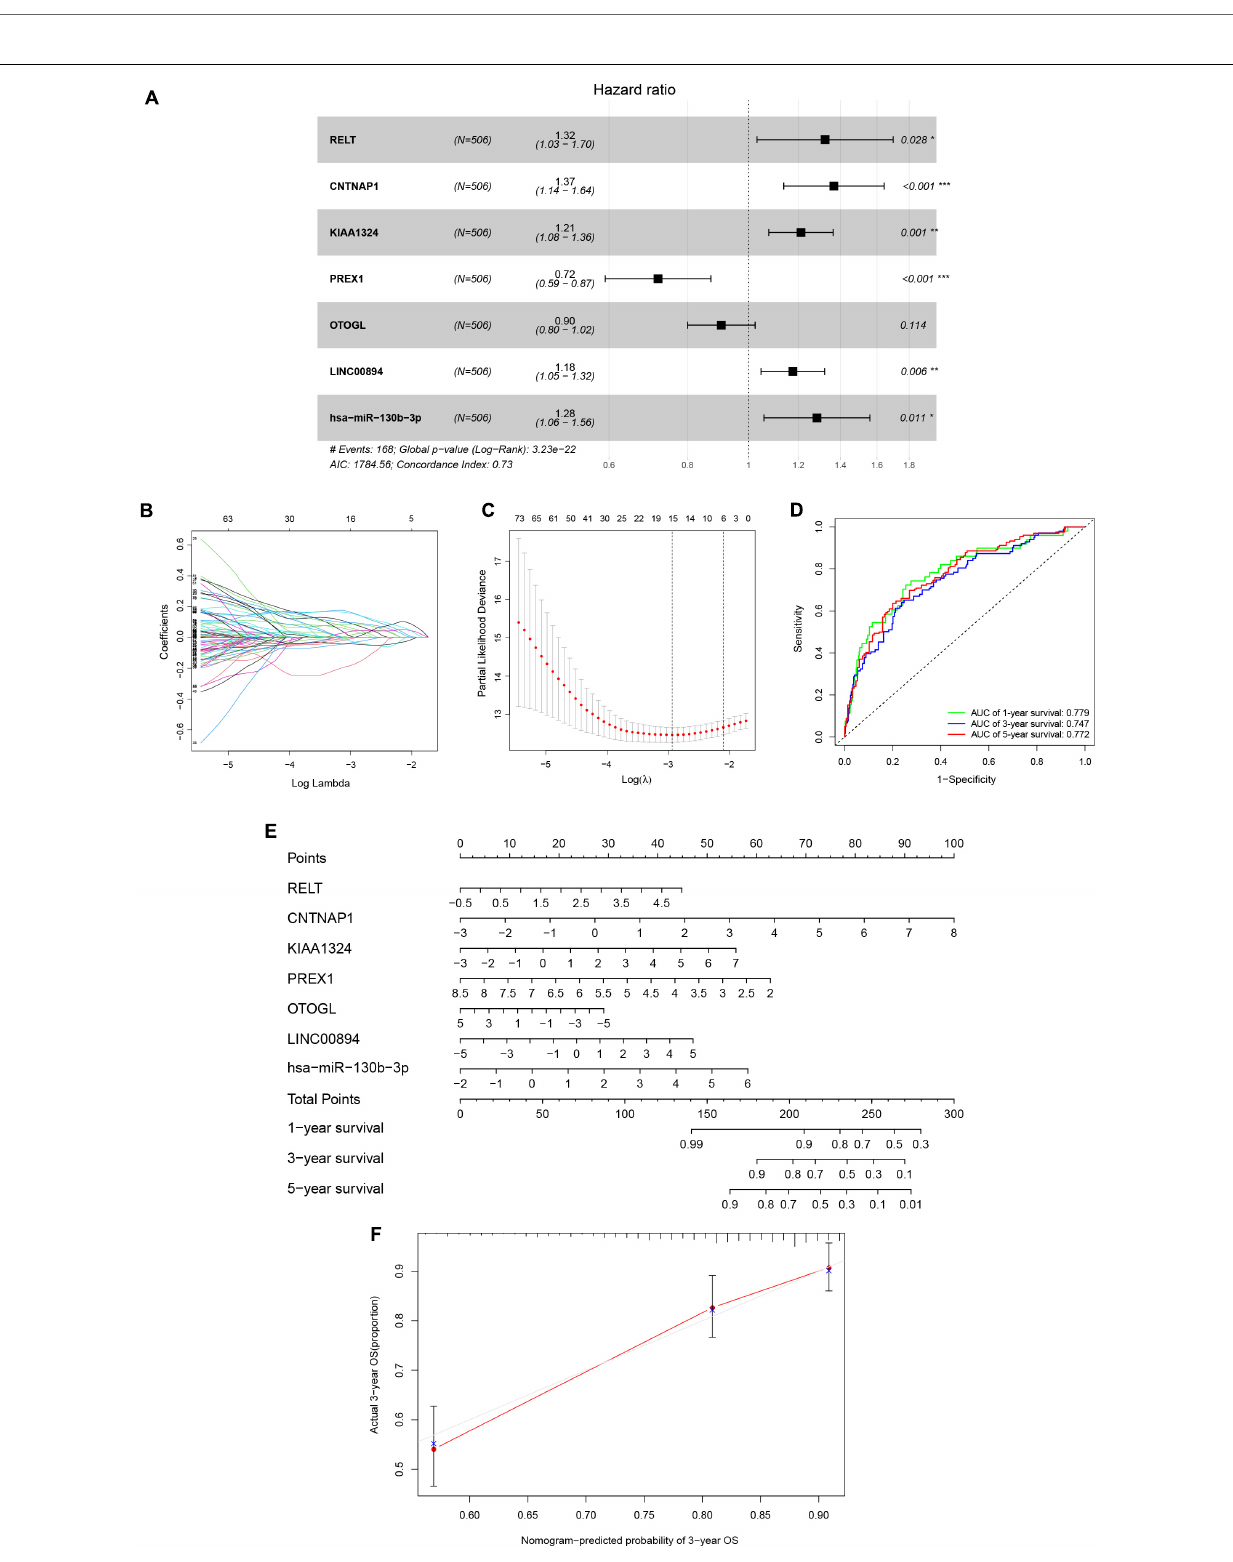
Frontiers in Genetics |